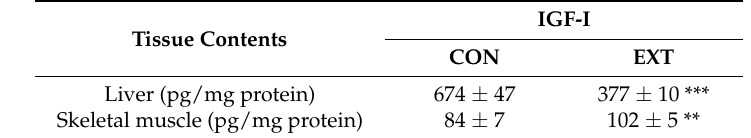
Table 1. IGF-I protein content in the liver and skeletal muscle (gastrocnemius) of rats after 14 days of habitual (CON) and extended (EXT) light–dark conditions (respectively 12:12 h and 16:8 h).